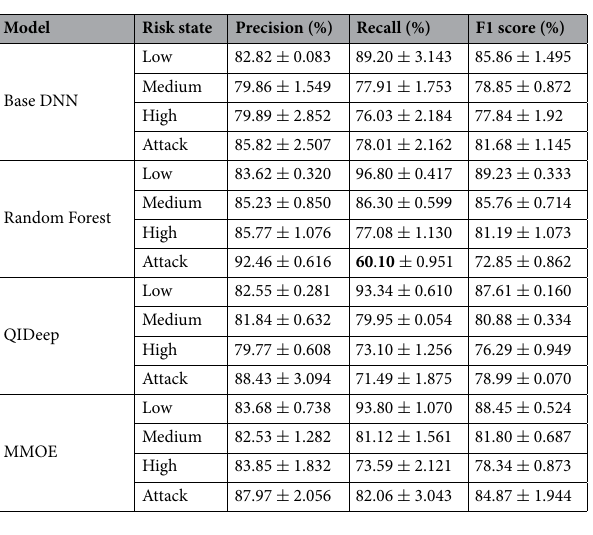
Table 2. Classification report of base DNN model, random forest (34 features) and QIDeep, MMOE (20 features). Significant values are in bold.